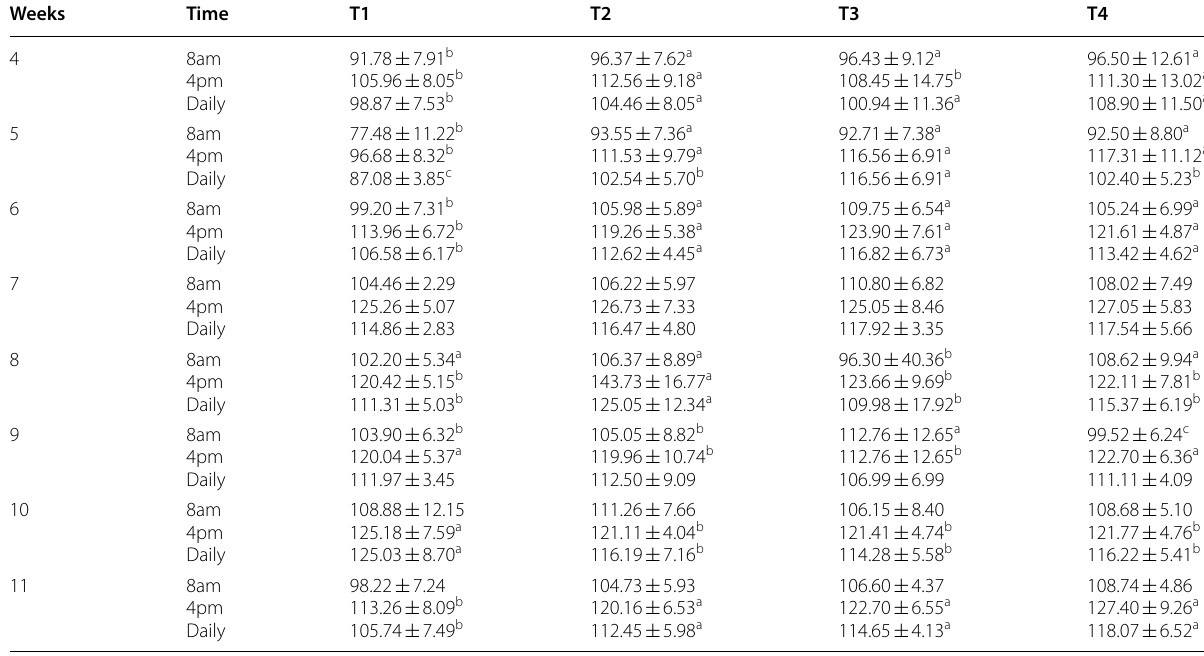
Table 2 Respiratory rate (breath/min) of heat-stressed bucks administered ascorbic acid and sodium bicarbonate and their